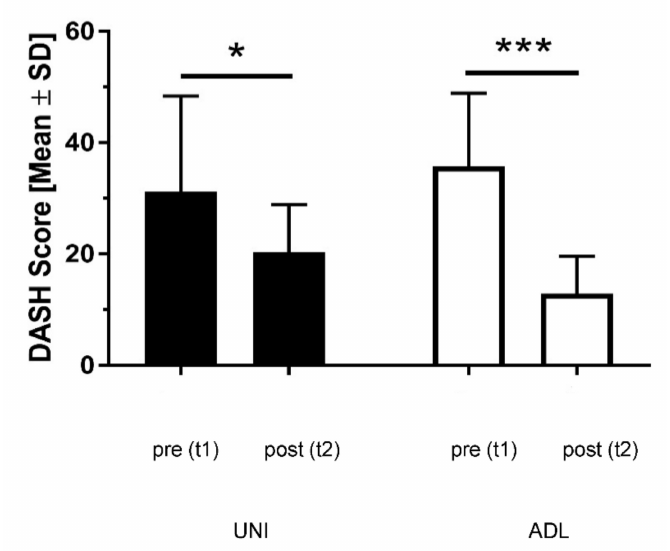
Figure 2. DASH score at t1 and t2 in the UNI-group and the ADL-group. Black columns: UNI-group; white columns: ADL-group; Asterisks indicating significance ( p < 0.05 for * and p < 0.001 for ***); t1: beginning of rehabilitation; t2: end of rehabilitation; SD: standard deviation.